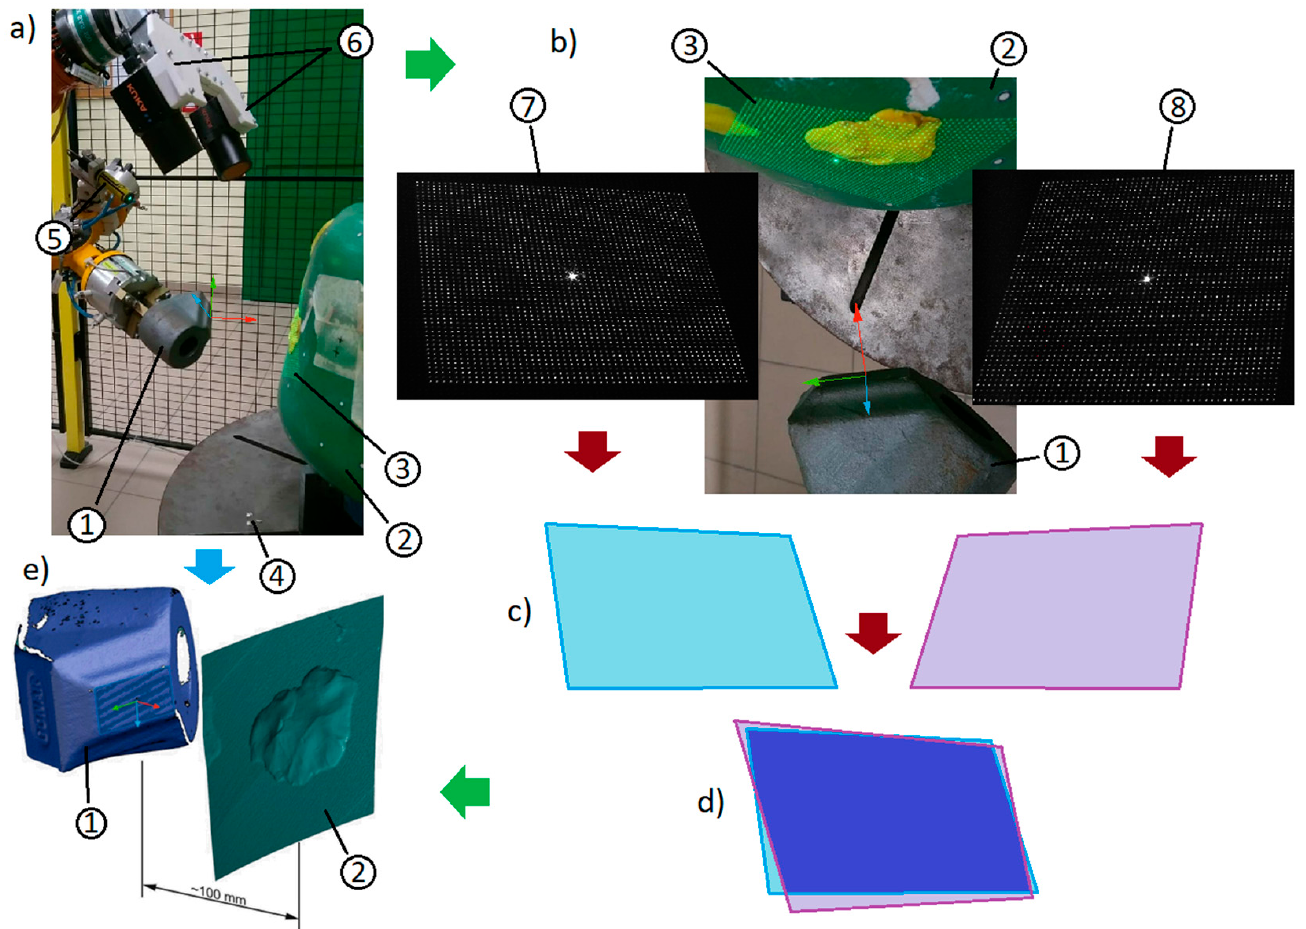
Figure 1. Stages of mapping the shape of the side surface of the working unit of the mining machine using the developed measuring method: ( a ) setting the cameras and laser projection device for the measurement; ( b ) acquisition of measurement images; ( c ) deformations of the grid of measurement points in the images; ( d ) transformation of the right image into the left image; ( e ) spatial model mapping the side surface in the area where the pick holder was mounted: 1—pick holder, 2—working unit, 3—projection of a marker grid, 4—positioner, 5—laser projection device, 6—stereovision system mounted on a robot, 7—image from the left camera, 8—image from the right